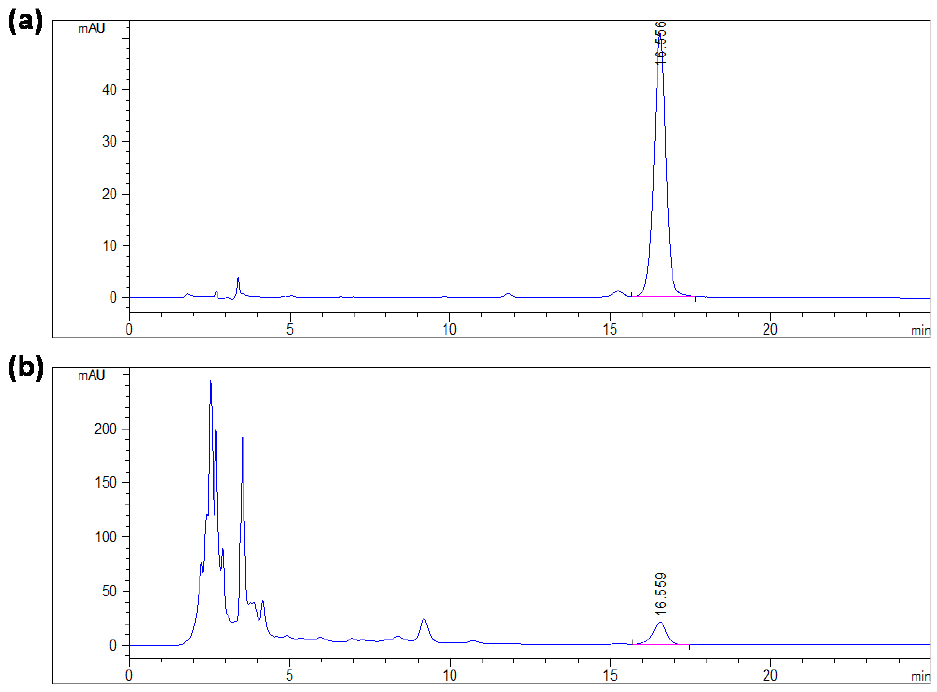
Figure A1. Typical HPLC chromatogram of the reference standard and the supernatant